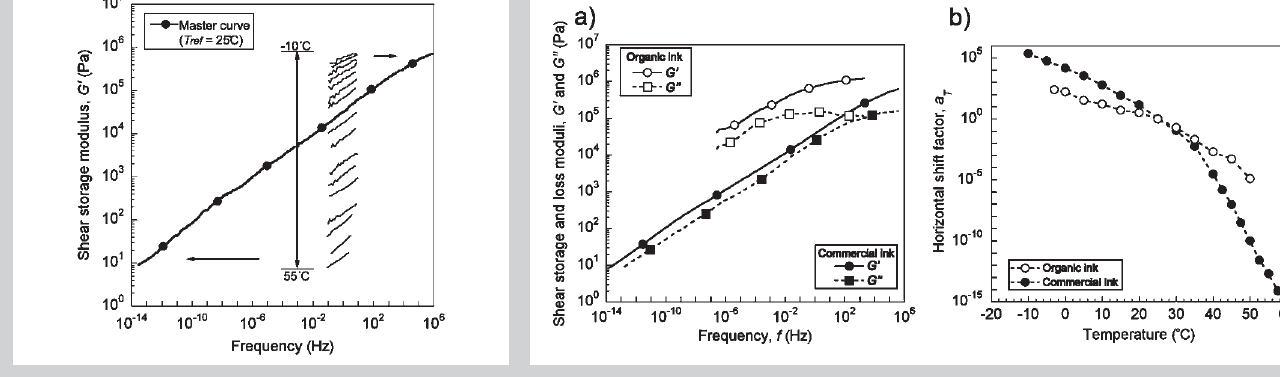
Figure 5 (left): Shear storage modulus mas- ter curve assembly for the commercial ink. Figure 6: Results of isothermal oscilla- tory shear rheometry exper- iments. a) Complex shear modulus master curves, T = 25 ∞ C. ref b) Shift factors used in mas- ter curve